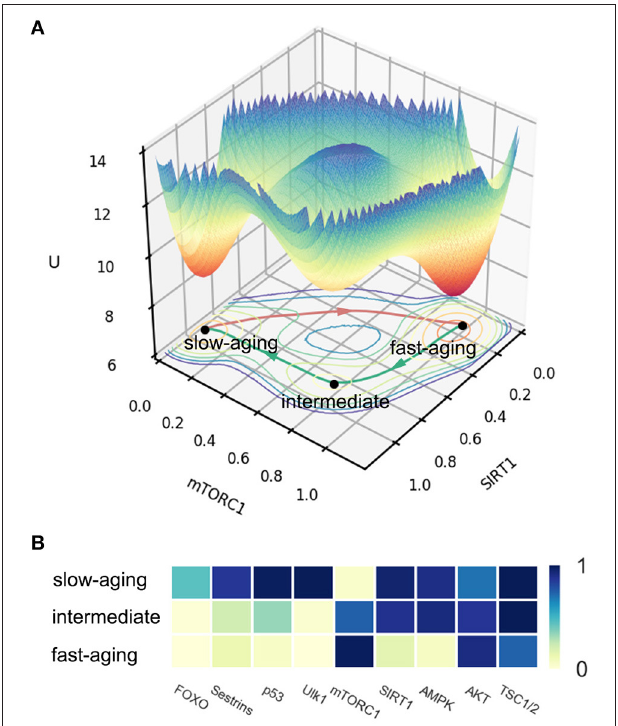
FIGURE 2 | The potential landscape and gene expression levels of fast-aging and slow-aging. Red arrows represent the dominant path from slow-aging to fast-aging. Green arrows represent the dominant paths from fast-aging to slow-aging. (A) The potential landscape of fast-aging and slow-aging. (B) Gene expression levels of fast-aging and slow-aging.